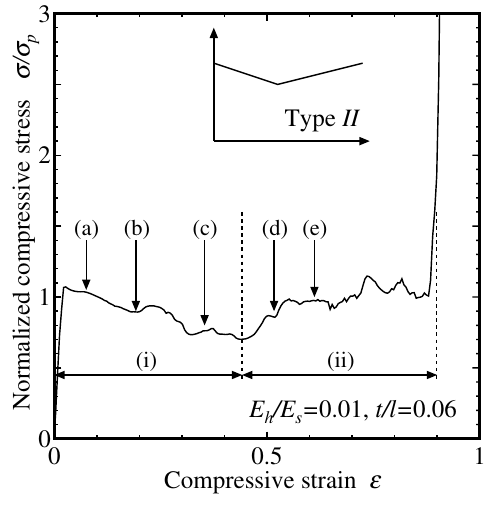
Figure 7. Typical stress-strain response of Type